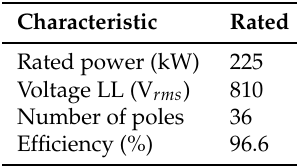
Table 2. Generator parameters at rated load.